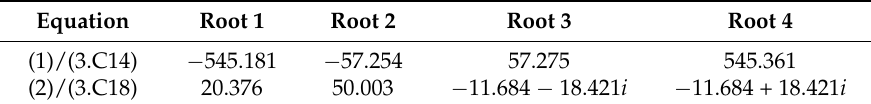
Table 1. Roots for the fourth-degree equations (1) and (2), Equations (3.C14) and (3.C18) in Supplementary Material.